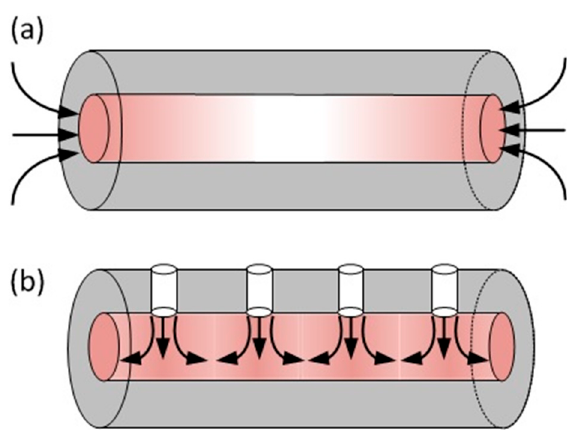
Figure 8. Comparison of two distributed chemical sensing schemes based on hollow-core fibres. ( a ) The analyte enters the air hole through the fibre ends; ( b ) the analyte enters the air hole through conduits along the fibre. The tint represents the concentration of the analyte.